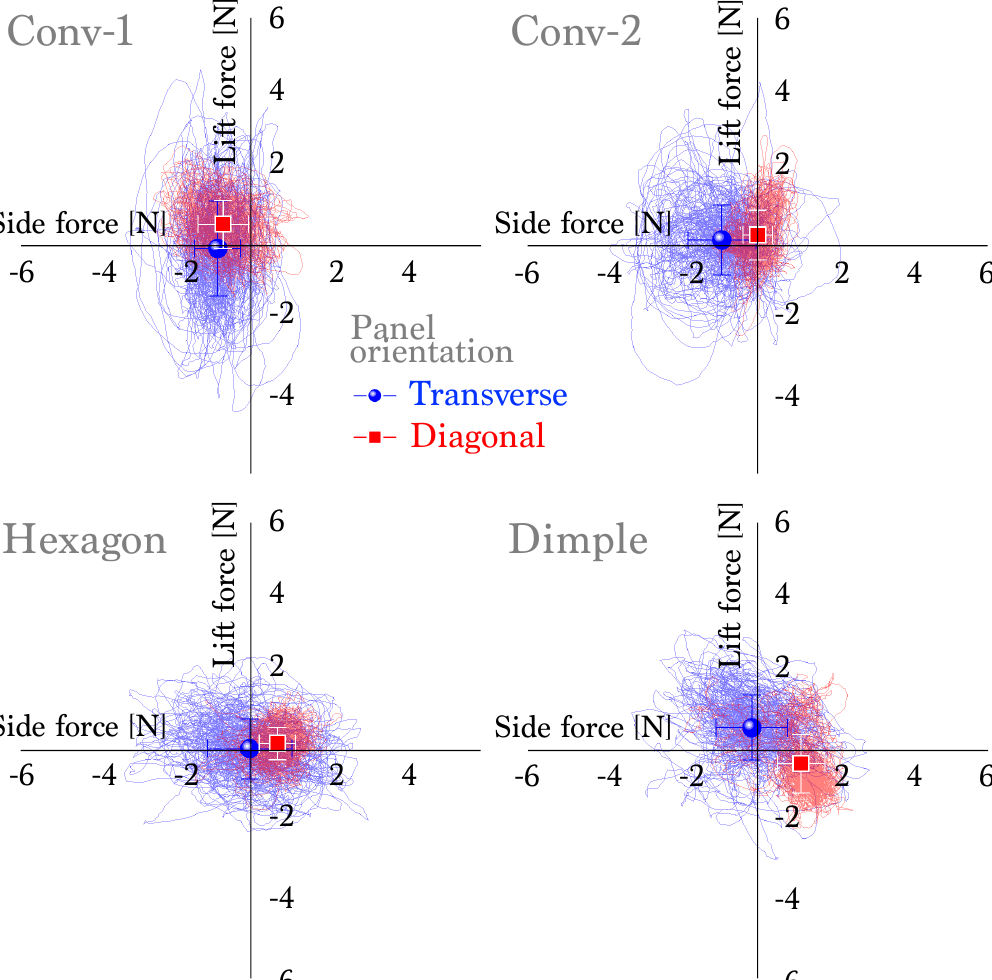
Figure 4. The lift and side forces acting on the ball taken in the wind tunnel experiment (10 s, wind speed 15 m/s) are quite isotropic from the balls with isotropic (Hexagon and Dimple) surface patterns. Blue and red represents transverse and diagonal directions, respectively. Big circles and squares are the average values with error bars taken from the standard